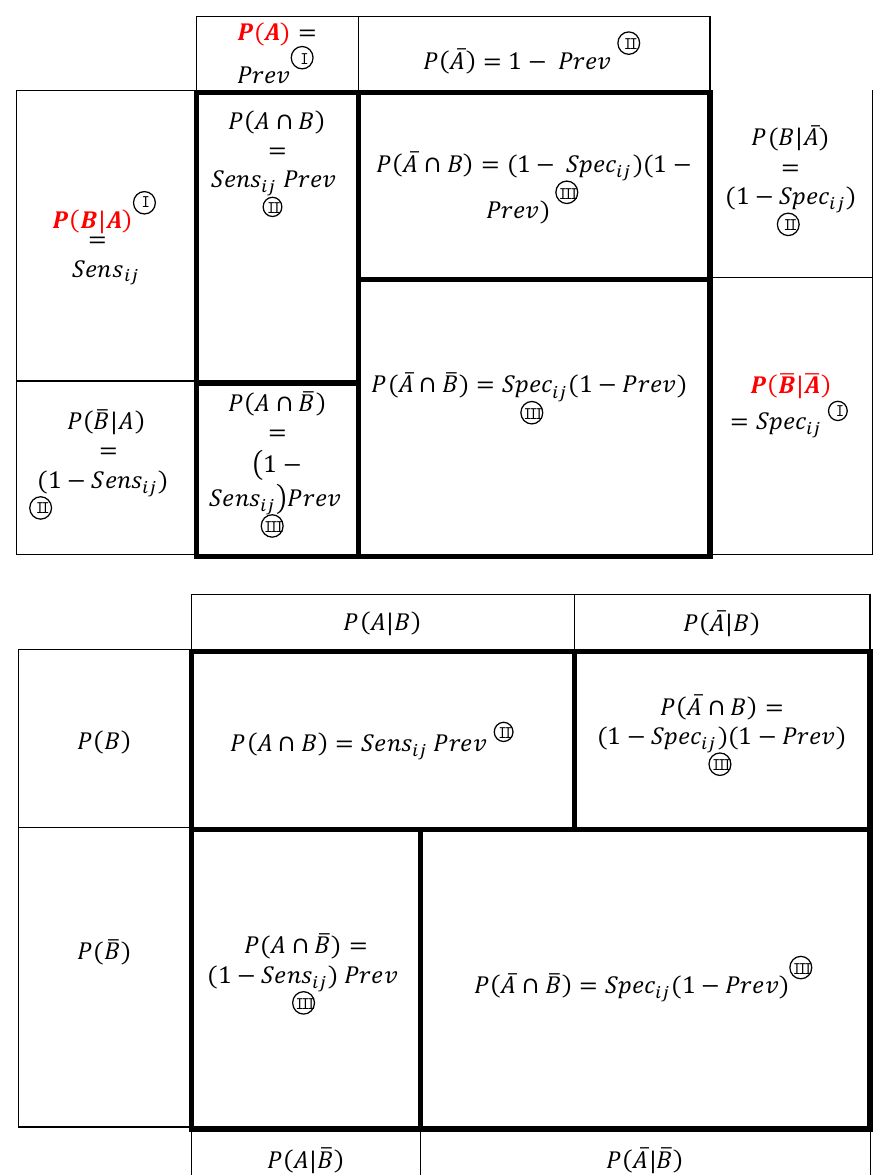
(𝑃(𝐴̅|𝐵̅)) in (𝑃(𝐴|𝐵)) and 𝑁𝑃𝑉 𝑖𝑗 𝑖𝑗 (𝑃(𝐵|𝐴)) and 𝑆𝑝𝑒𝑐 𝑖𝑗 𝑖𝑗